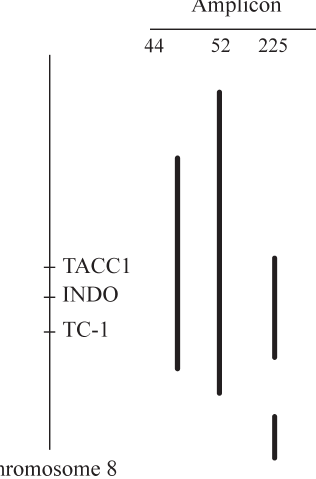
Figure 3 - Ideogram of the 8p11-p12 amplicon in three HBC cell lines, SUM-44, SUM-52 and SUM-225 showing the conserved region (modi- fied from Yang et al. ,